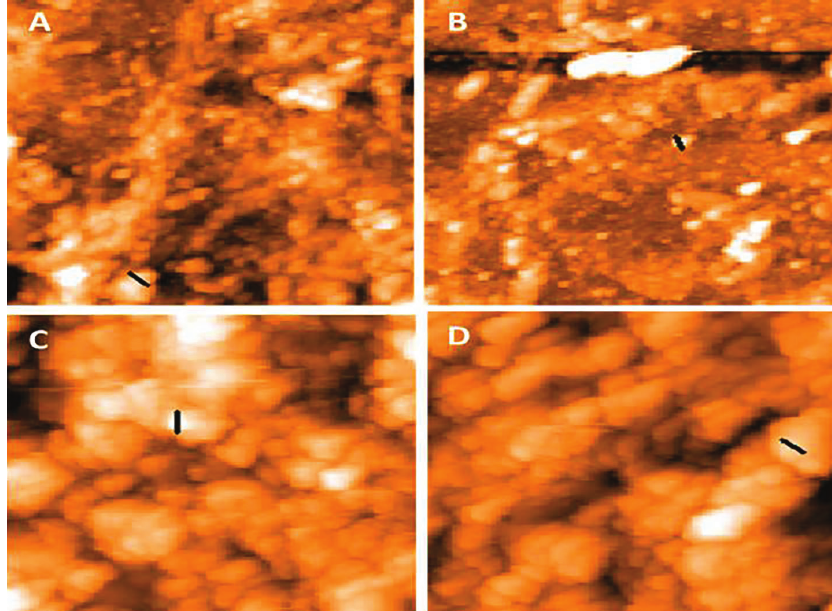
measured at 430 nm in a UV-vis sepectrophotometer. 3